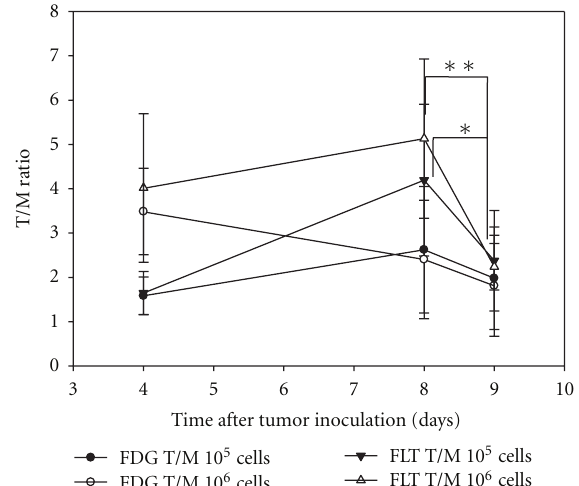
Figure 3: Tumor-to-muscle ratio of 18 F-FLT and 18 F-FDG in 10 5 and 10 6 tumor cells inoculation obtained from biodistribution. There were significant di ff erences in the detection of microPET-FLT between day 8 and day 9. (mean ± SD, n = 5; ∗ P < 0.05; ∗∗ P < 0.01).